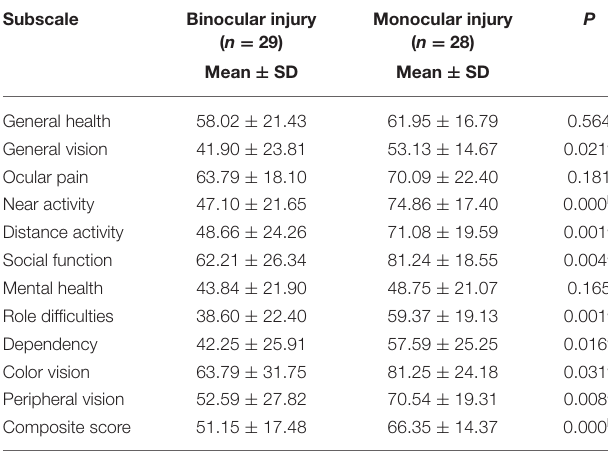
TABLE 3 | Analysis of each subscale and composite score between patients with monocular incidence and binocular incidence. Subscale Binocular injury ( n = 29)